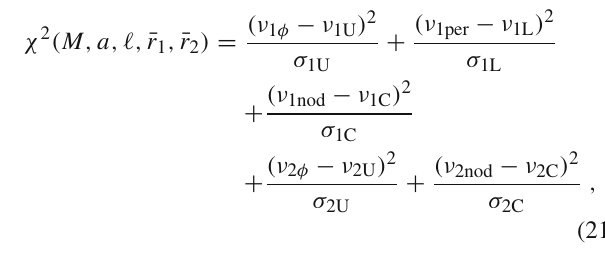
SV metric with M = 1. The a = 0 case corresponds to the SV metric, which has ν nod = 0 due to spherical symmetry. Except ν nod with a = 0, the magnitudes of ν φ , ν per and ν nod decrease as (cid:5) grows with a fixed a . For the retrograde orbits in the rotating SV metric with a > 0, the values of ν nod are shown to be